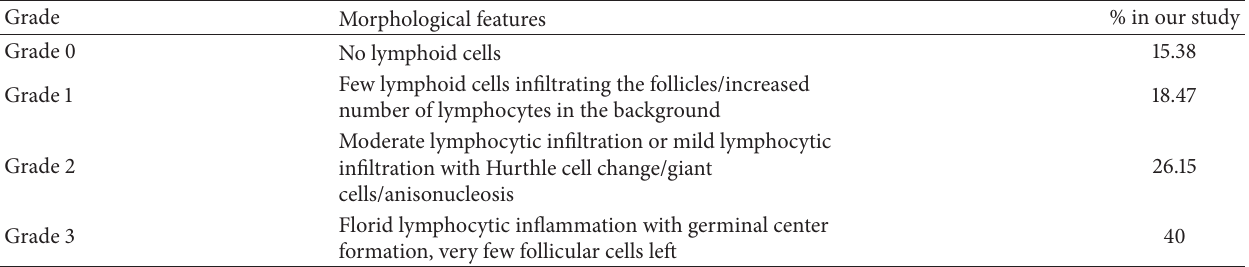
Table 1: Grading of thyroiditis on cytological material.